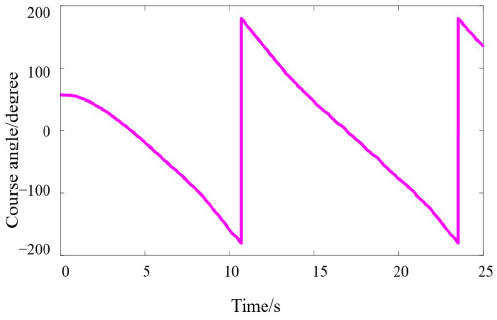
Figure 11. Results of the rotation motion experiment of a single